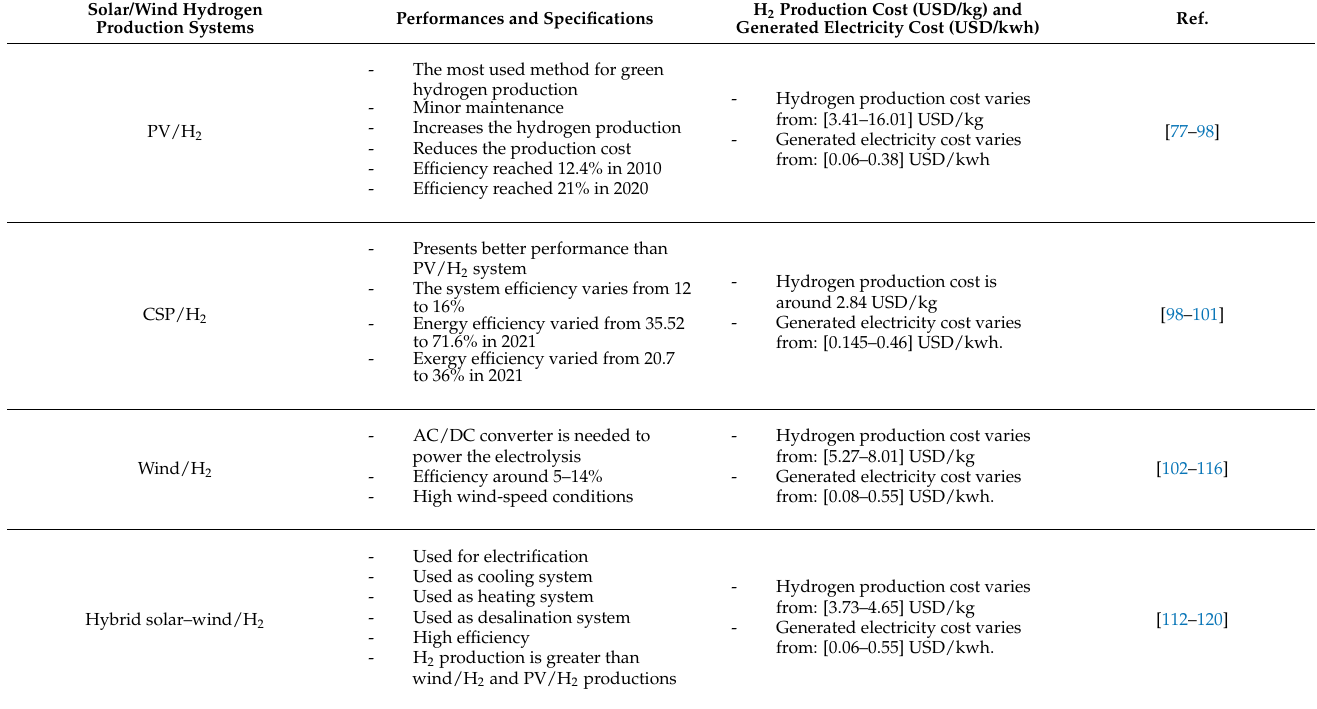
Table 6. Specifications of Solar/Wind/H 2 production